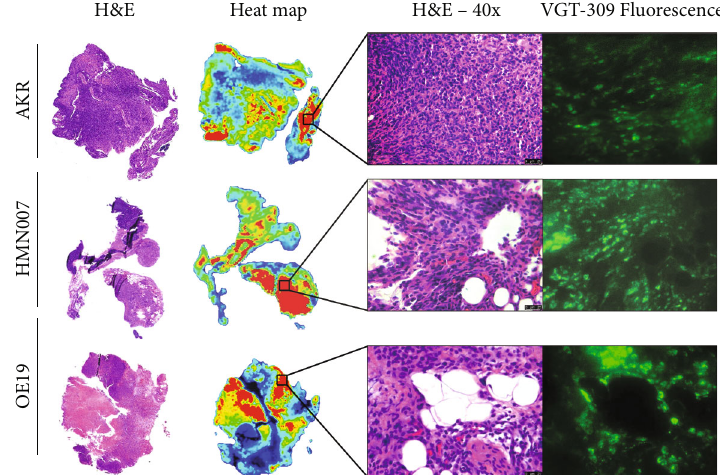
Figure 6: VGT-309 labels esophageal cancer fl ank tumors during resection. (a) Representative tissue sections from all three cell lines stained with hematoxylin and eosin and imaged with the Odyssey NIR imaging system. (b) High magni fi cation microscopy images showing H&E staining and fl uorescence microscopy from the same area of